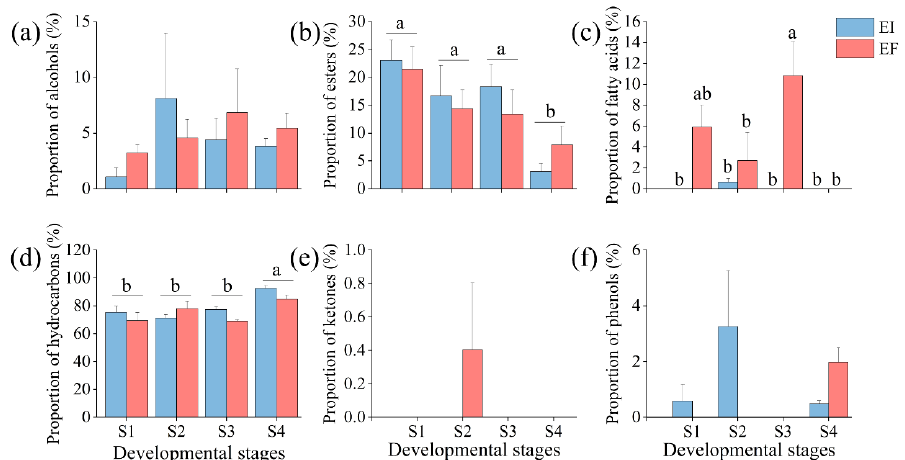
Figure 1. Composition and proportion of leaf cuticular wax in Achnatherum inebrians according to the status of Epichloë gansuensis endophytes and in different growing periods (S1: 1 month after sowing, S2: 2 months after sowing, S3: 3 months after sowing, S4: 4 months after sowing, EI: endophyte-infected and EF: endophyte-free).